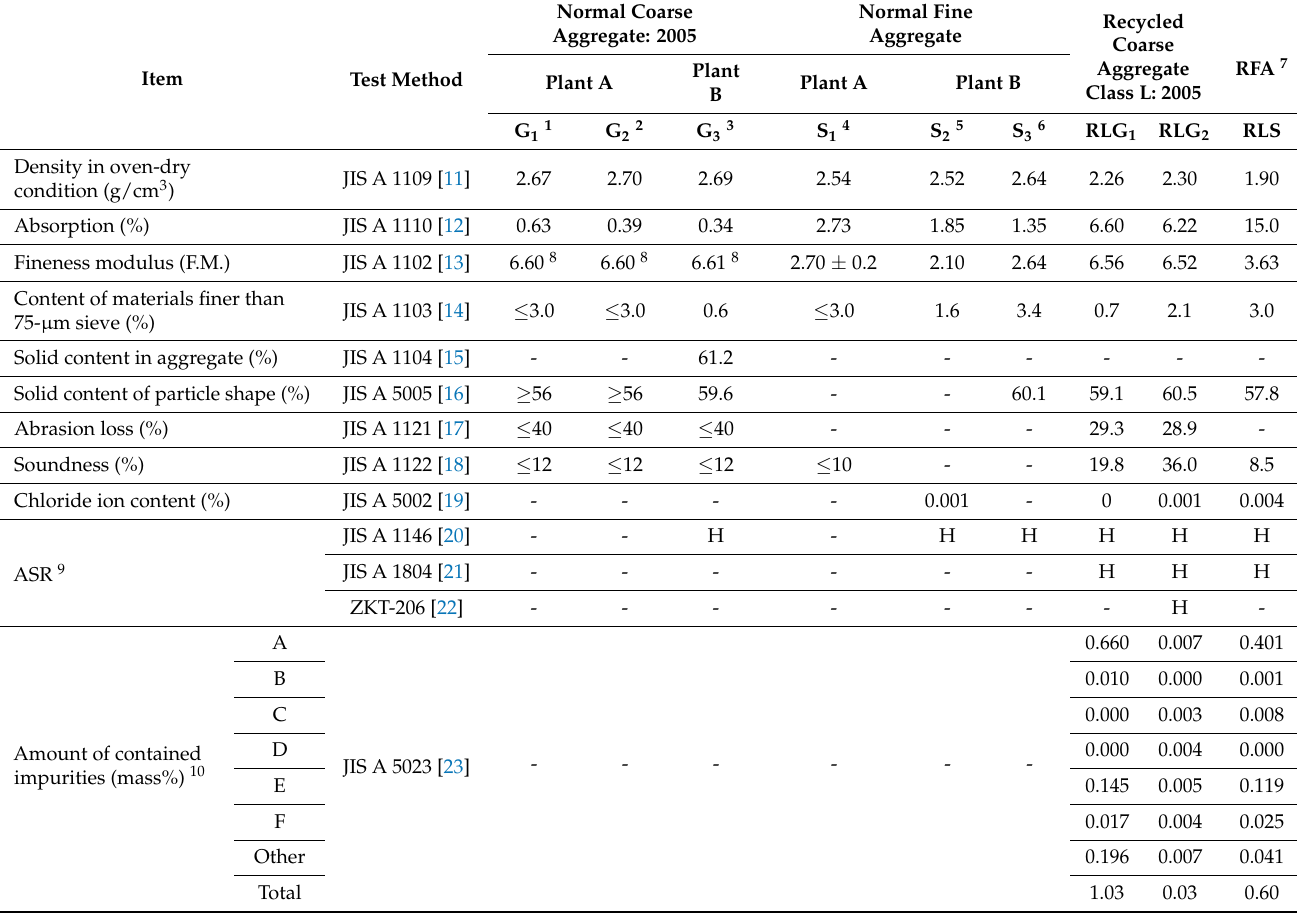
Table 5. Qualities of